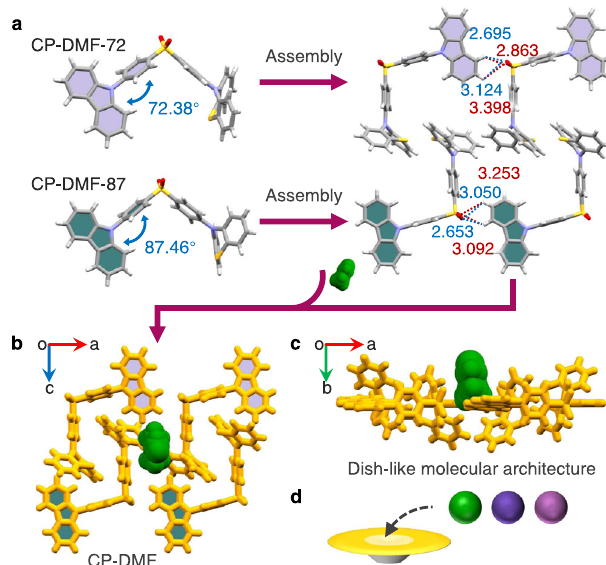
Fig. 2 | Single-crystal structural investigation of CP-DMF. a Two types of bimolecular units assembled from two CP-DMF-72 molecules (upper) and two CP- DMF-87 molecules (lower) in the single-crystal structure of CP-DMF. Color code: gray, C; red, O; blue, N; yellow, S; white, H. The dish-like molecular self-assembly architecture with a small cavity along b the b -axis and c the c -axis of the single- crystalstructure, inwhichaDMFguest moleculeisaccommodatedinitscavity.CP and DMF molecules are colored yellow and green, respectively. d Schematic dia- gram of the dish-like molecular architecture occupied by various guest